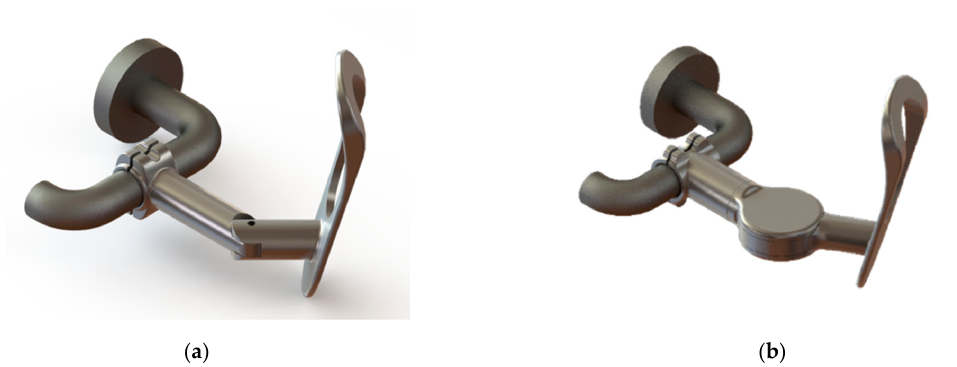
Figure 6. Three-dimensional visualization: ( a ) ADOD-V6 system; ( b ) ADOD-V7 system.